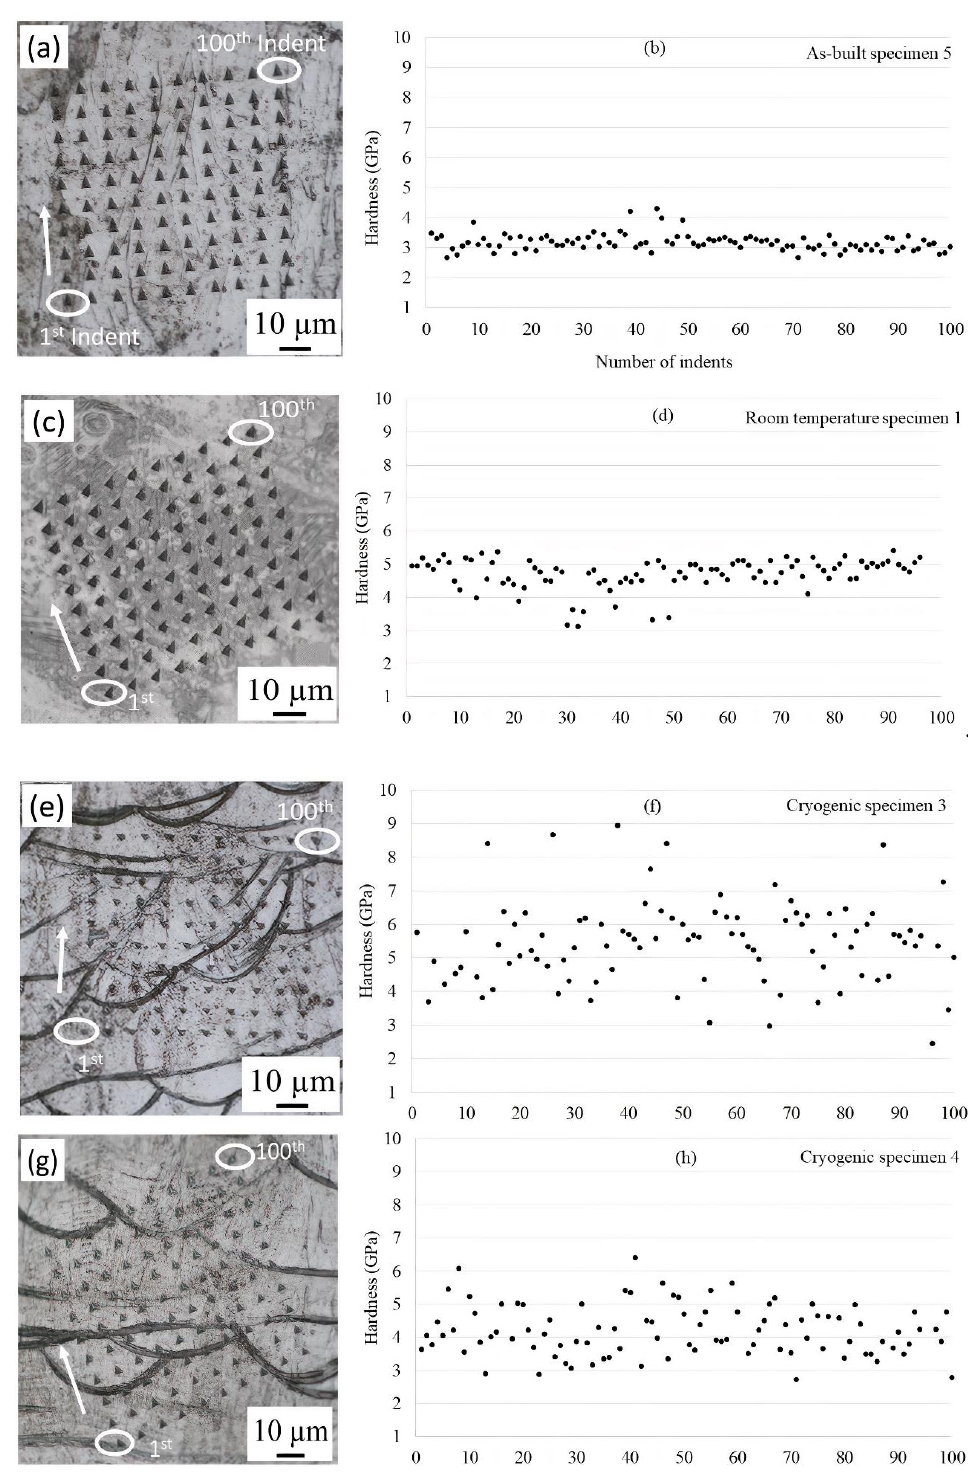
Figure 7 . Nanoindentations in 316 L under different conditions: ( a , b ) as-built specimen 5, ( c , d ) room-temperature specimen 1, ( e , f ) − 196 °C temperature specimen 3 and ( g , h ) − 196 °C temperature specimen 4. A load of 60 mN was applied. Indents were performed in a 10*10 matrix. The distance between two indents was 12 µm. After tensile testing at room temperature (specimen 1), the nanoindentation hardness values ranged from 3 to 5 GPa, which is higher than that observed for the as-built speci- men (Figure 7c,d). Furthermore, the XRD measurements confirmed that no martensitic transformation occurred at room temperature, and thus, no martensite was observed be- fore or after deformation at room temperature. Therefore, the increase in hardness after tensile testing at room temperature could be explained by the deformation and thus the formation of dislocations and twins, as reported by Qiu et al. [34] and Liu et al. [54] for 316 L after tensile testing. At −196 °C, the nanoindentation result of specimen 3 shows a larger hardness spread in the material, ranging from 3 to 9 GPa (Figure 7e,f). This could be attributed to the new phases formed during tensile testing at −196 °C, as indicated by the XRD results. That is, the softer areas are attributed to austenite, and harder areas are attributed to ε and α mar- tensite. In the −196 °C temperature specimen 4 (Figure 7g,h), the hardness values ranged from 3 to 6 GPa. However, there were very few hardness values above 6 GPa. This indi- cates that less martensite was present in specimen 4 than in specimen 3, which is in agree- ment with the Rietveld refinement of the XRD results. Heidarzed et al. [55] reported 6 GPa for the nanohardness of HCP ε martensite in L-PBF samples after high-pressure torsion (HPT). The average Vickers microhardness values of the four specimens are summarized in Table 5. The Vickers microhardness values follow the same trend as the results from the tensile tests. It also agrees with the XRD results and the fraction of microsconstituents, i.e., that the sample containing the largest amount of martensite shows the highest micro- hardness value and that the as-built material shows the lowest. The increase in plastic deformation and decrease in temperature promote the formation of martensite transfor- mation and increase the hardness of the material. Several parameters influence martensite formation, such as chemical composition, stress applied, plastic strain, and temperature [27, 33, 42]. The high hardness of martensite results from different origins: the tetragonal lattice contains supersaturated interstitial carbon and a high density of dislocations result- ing from the displacive mode of formation [44, 56 – 58]. The higher cryogenic lattice re- sistance initiates thermally activated dislocation slipping. The presence of martensite, which has a very high hardness and strength, and the soft austenite phase in the micro- structure contribute to both the high strength and ductility under cryogenic conditions. It is noted that the fine-grained 316 L sample at −196 °C has a higher elastic limit strength than that at RT, and this is attributed to the high cryogenic lattice resistance for initiating thermally activated dislocation slipping as discussed by Jung et al. [19], Li et al. [41], and Sun et al. [59].